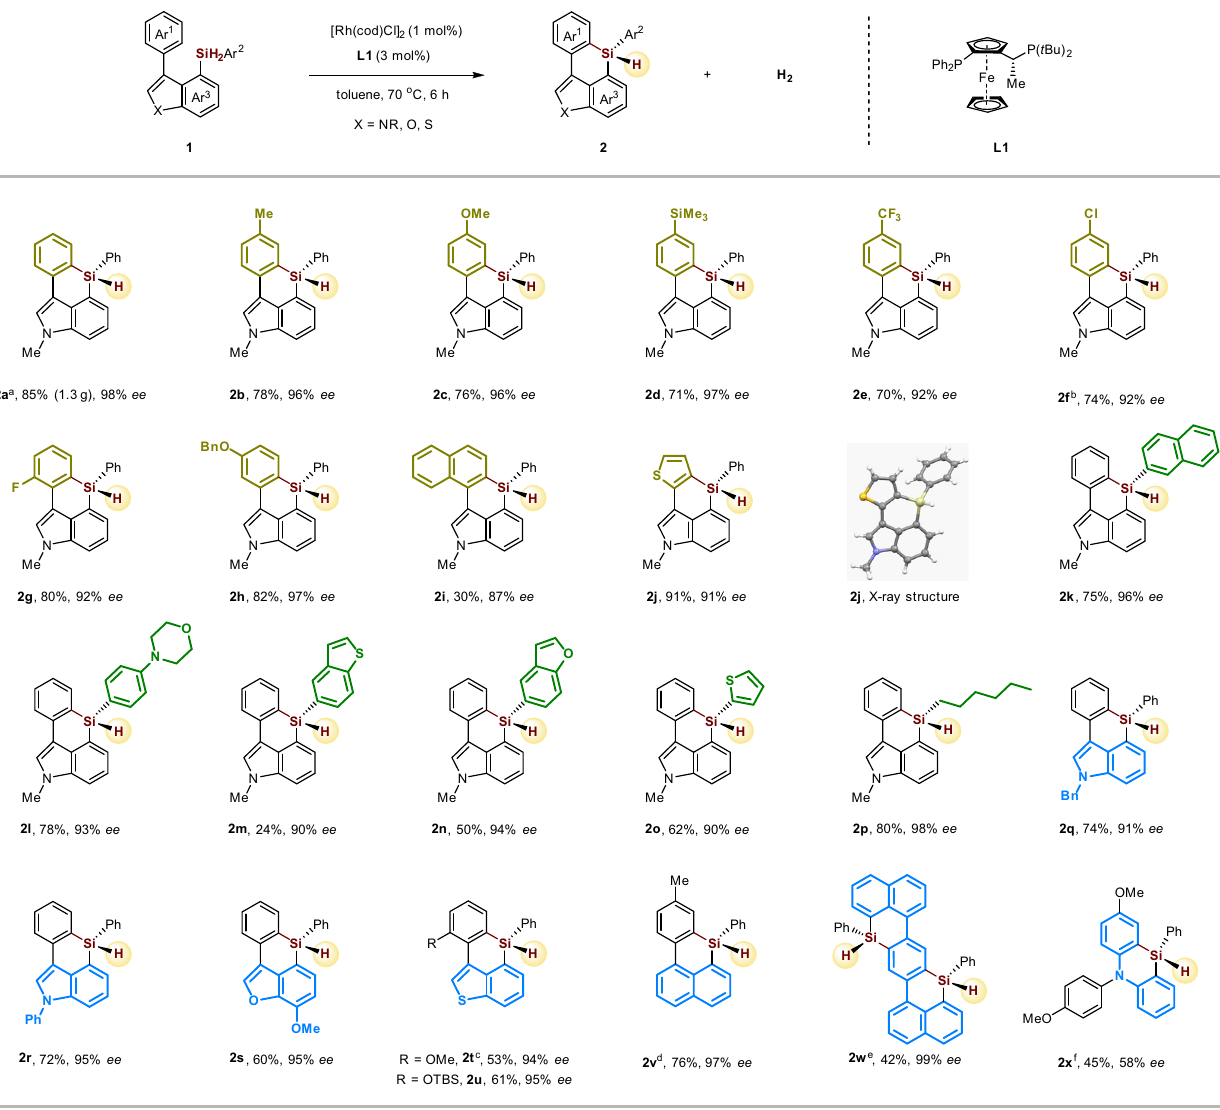
Fig. 3 Scope of six-membered triorgano-substituted silicon-stereogenic heterocycles. Reaction conditions: 1 (0.1 mmol), [Rh(cod)Cl] 2 (1mol%), L1 (3mol%) in toluene (1mL) at 70°C for 6 h. a Reaction was performed at 5mmol scale. b L5 was used as ligand. c [Rh(cod)Cl] 2 (4 mol%), L1 (8mol%) was used. d [Rh(cod)Cl] 2 (2mol%), L1 (4mol%) in toluene (1 mL) at 60°C for 8 h. e [Rh(cod)Cl] 2 (2 mol%), L1 (6mol%) was used. f L7 was used as ligand.